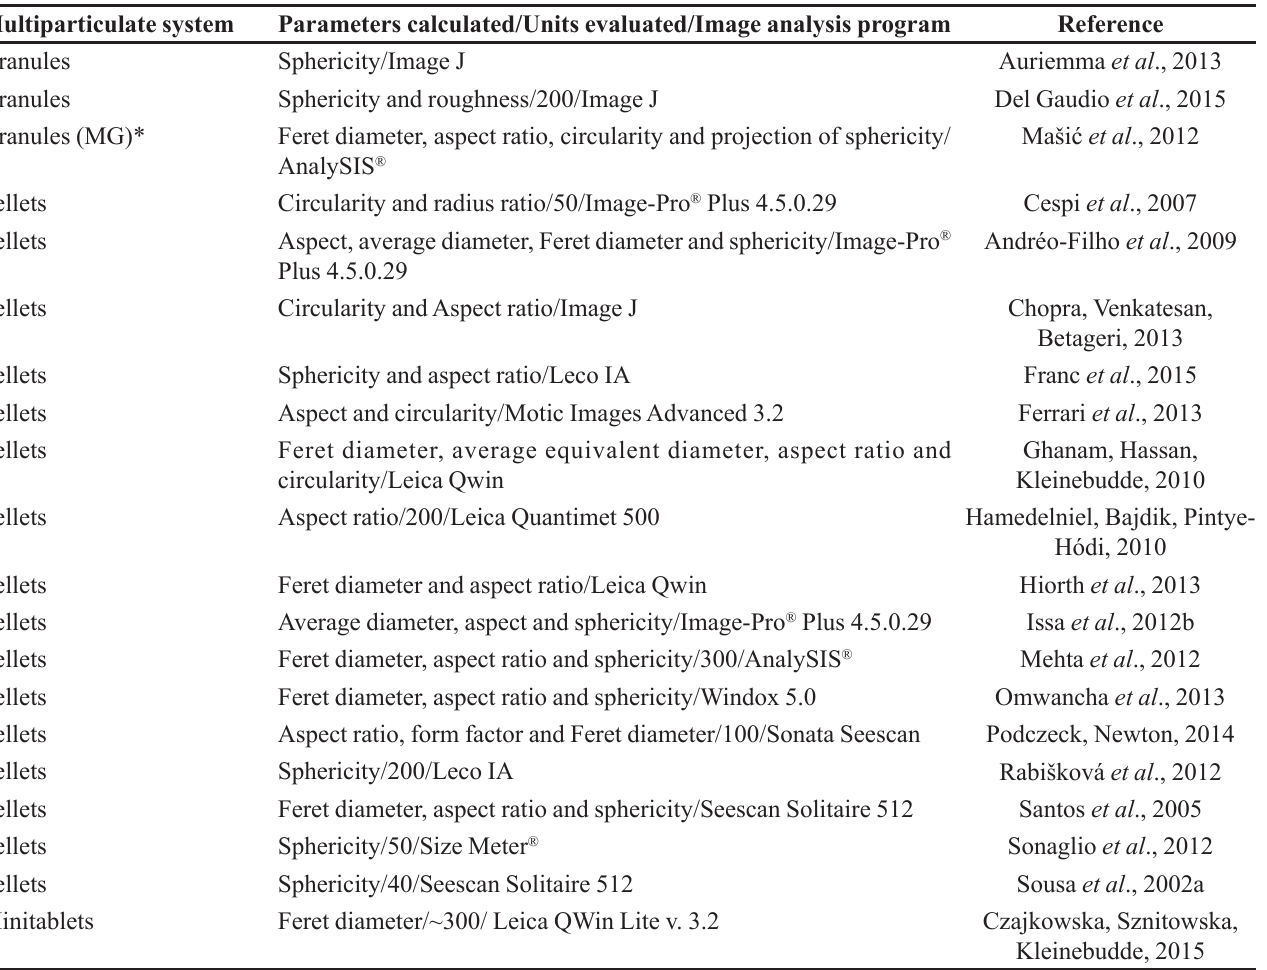
TABLE II - Shape parameters calculated based on analyses of microscopic images in multiparticulate systems Multiparticulate system Parameters calculated/Units evaluated/Image analysis